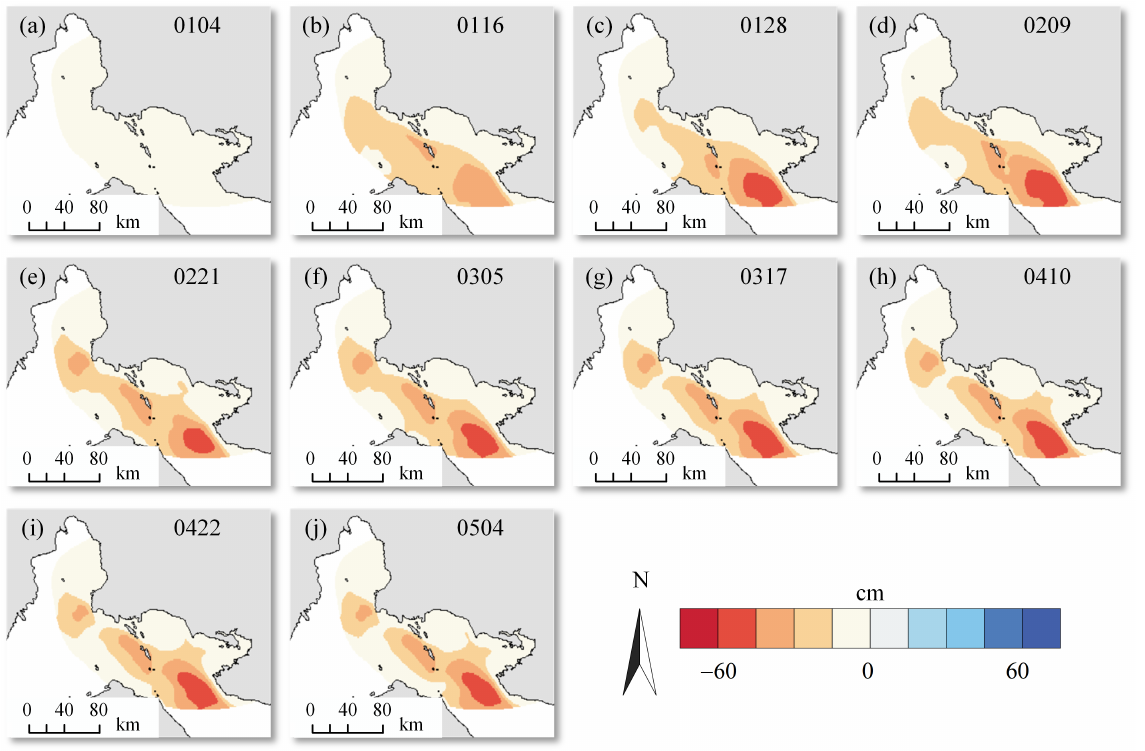
Figure A3. Filtered interferograms from ascending [( a – c ): 2019, ( d – f ): 2020, and ( g – i ): 2021].